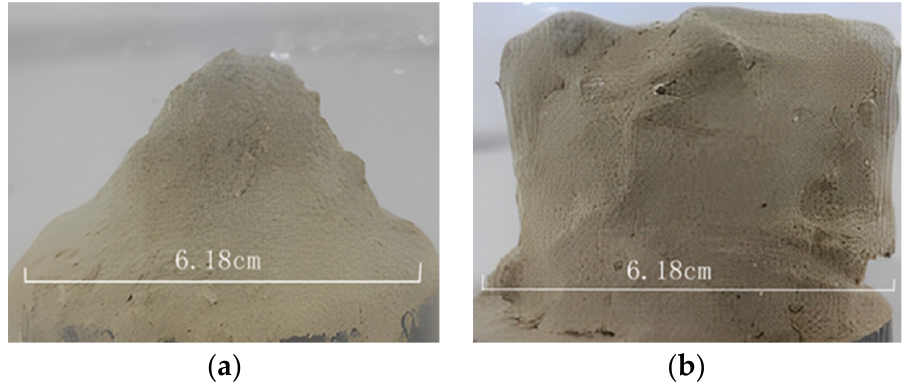
Figure 6. Comparison of disintegration process with and without cement. ( a ) η = 0 ( b ) η =